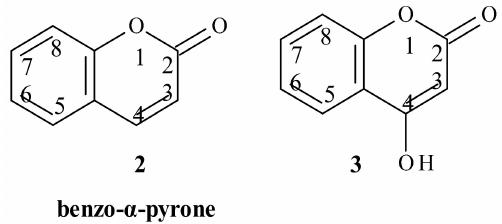
Figure 2. Structures of coumarin and